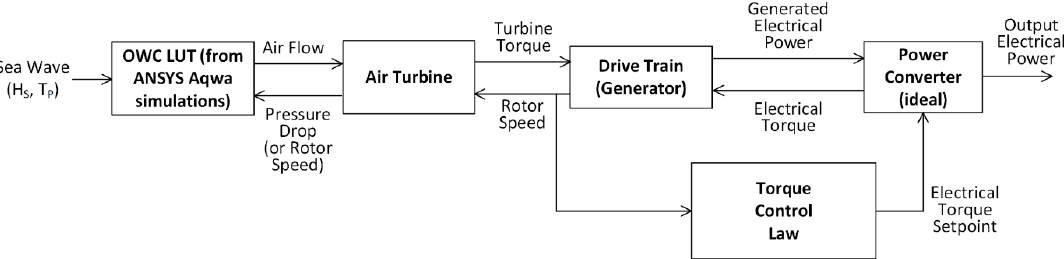
Figure 12. PTO block diagram for Simulink modeling.